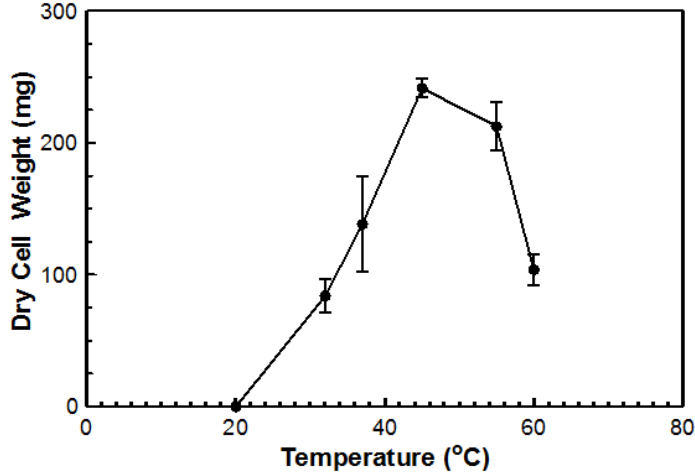
Figure 5. Dry cell mass of fungal growth in a liquid culture at various temperatures.